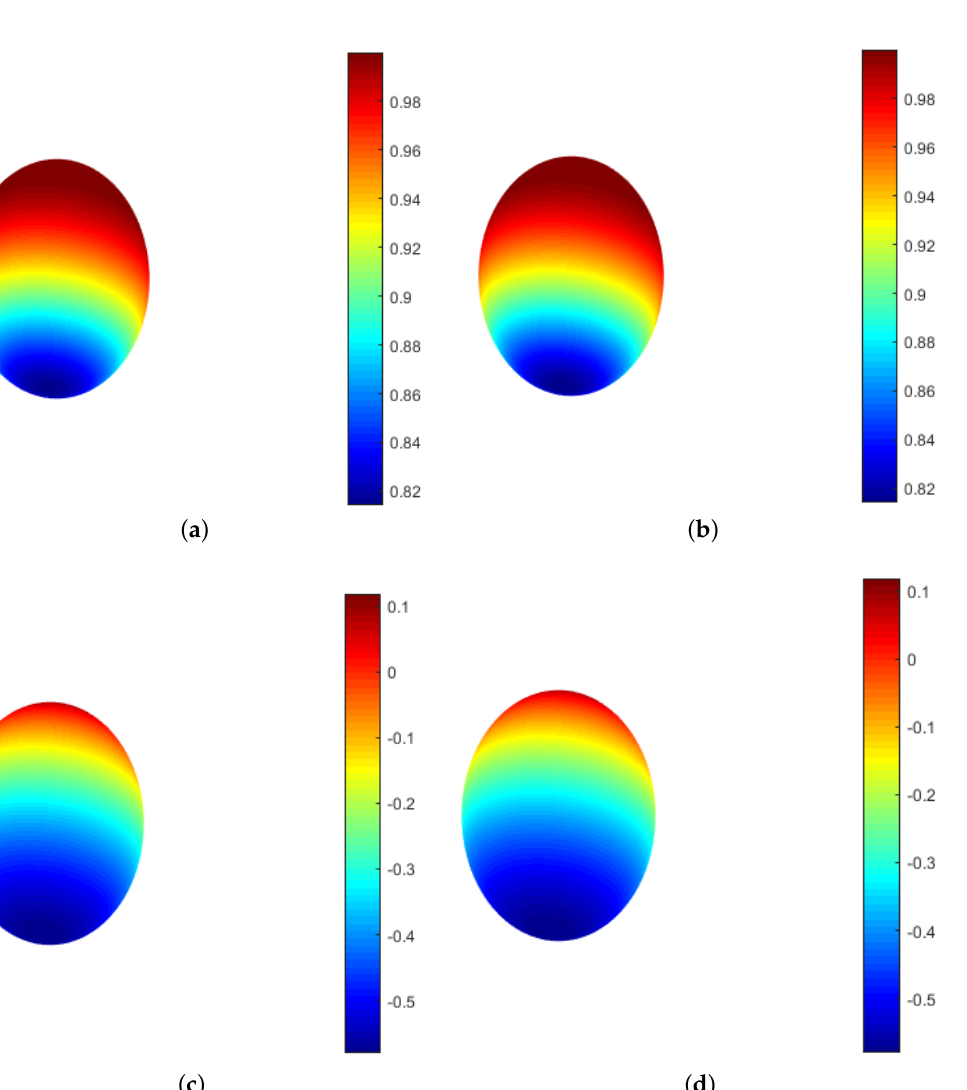
and τ = 0.5 dx 2 8